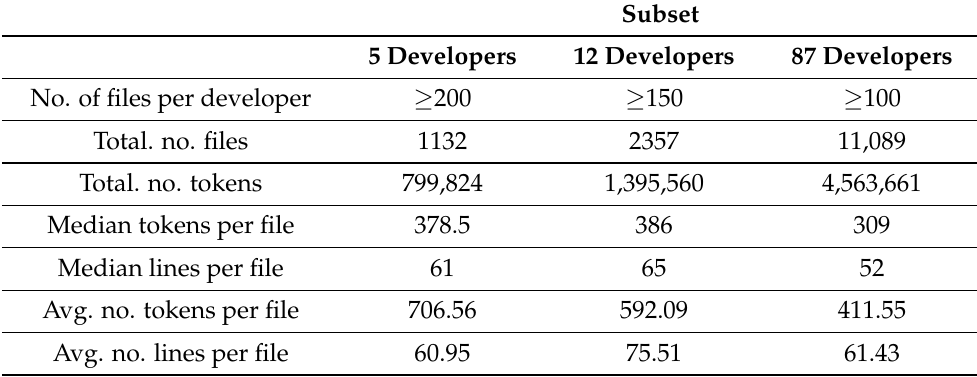
Table 1. Data set